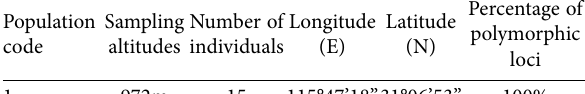
Table 1 The location of R. simsii populations studied sampled from Wujiashan